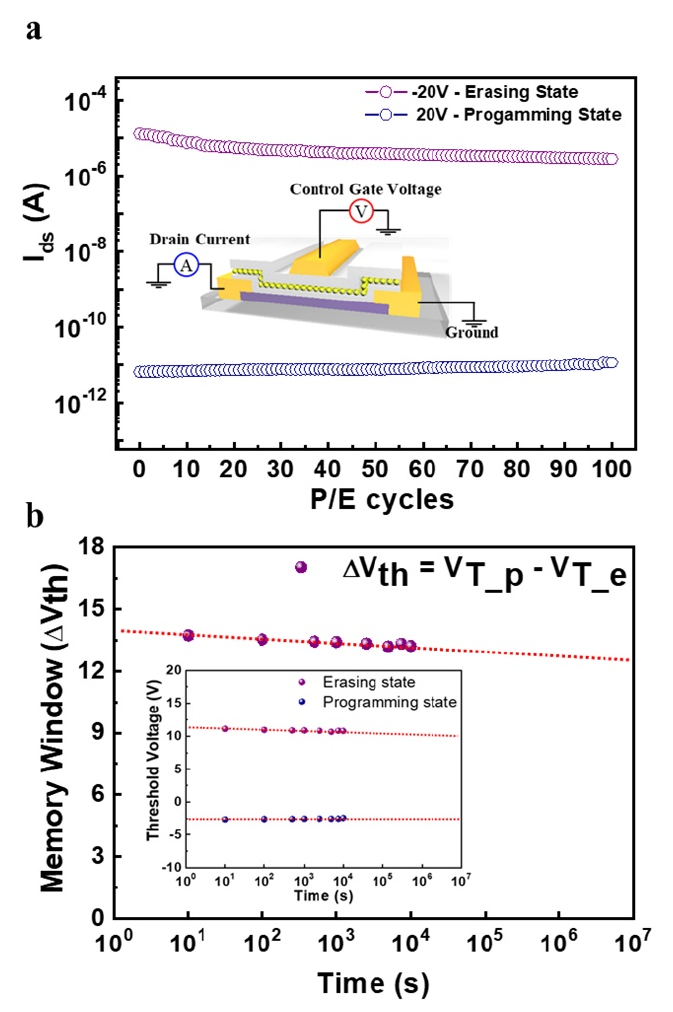
Figure 5. Memory operation of the proposed NVM device. ( a ) An endurance characterization of the proposed NVM device by applying a sequence of pulses (±20 V, duration of 100 ms) to the control gate at the V ds of 1 V up to 100 P/E cycles. ( b ) A retention characterization of the proposed NVM device in form of a memory window ( Δ V th ) at different time scales up to 10 4 .